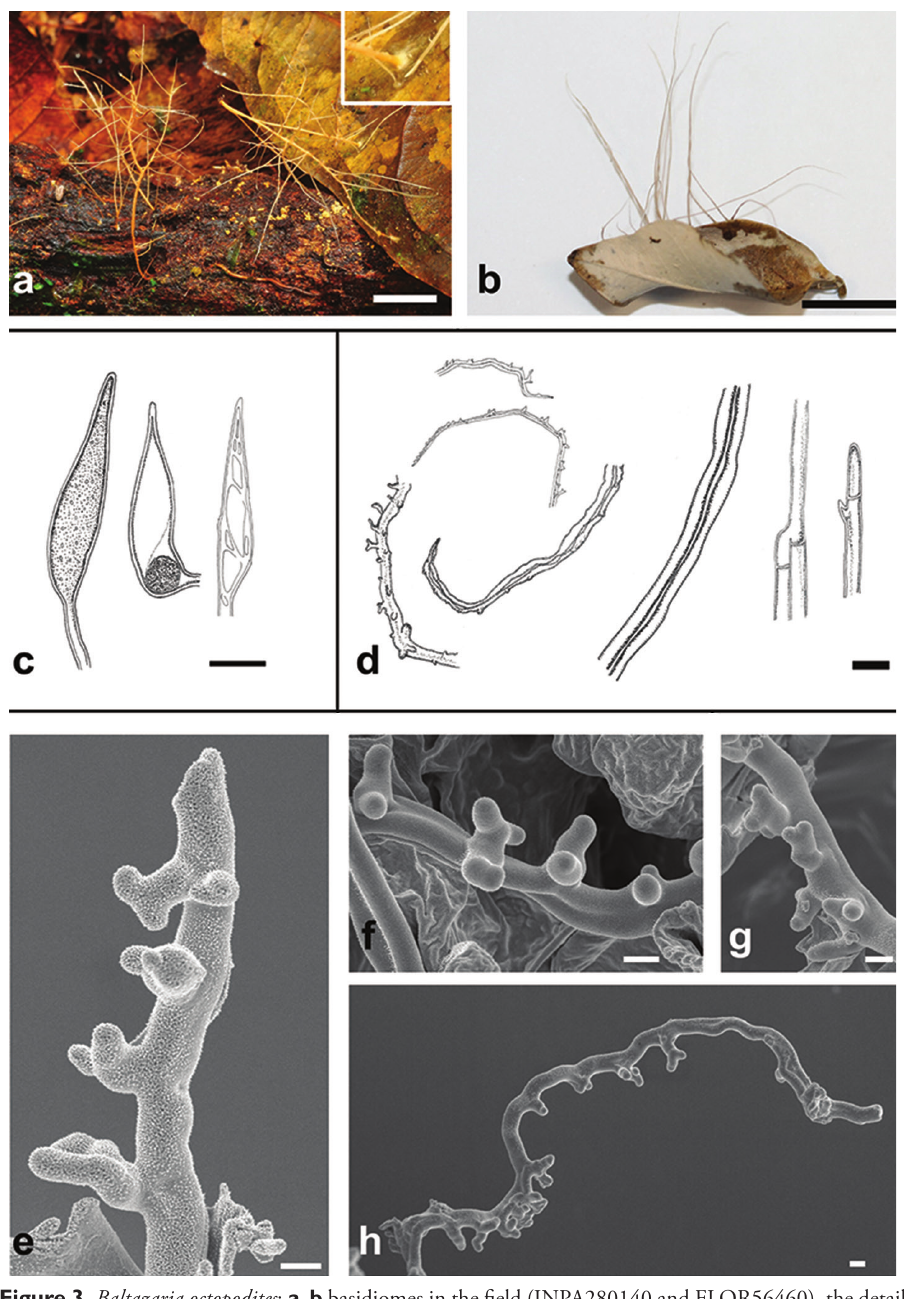
Figure 3. Baltazaria octopodites : a, b basidiomes in the field (INPA280140 and FLOR56460), the detail in a shows the anchorage point in the leaf, the whitish resupinate area in b shows the corticioid portion of the fungus c gloeocystidia d skeletal hyphae, skeletal hyphae inflated in KOH (third from the right) and generative hyphae (first and second from the right) e–h SEM images of papillate skeletal hyphae. Scale bars: a–b = 1 cm; c–d = 10 µm; e–h = 1